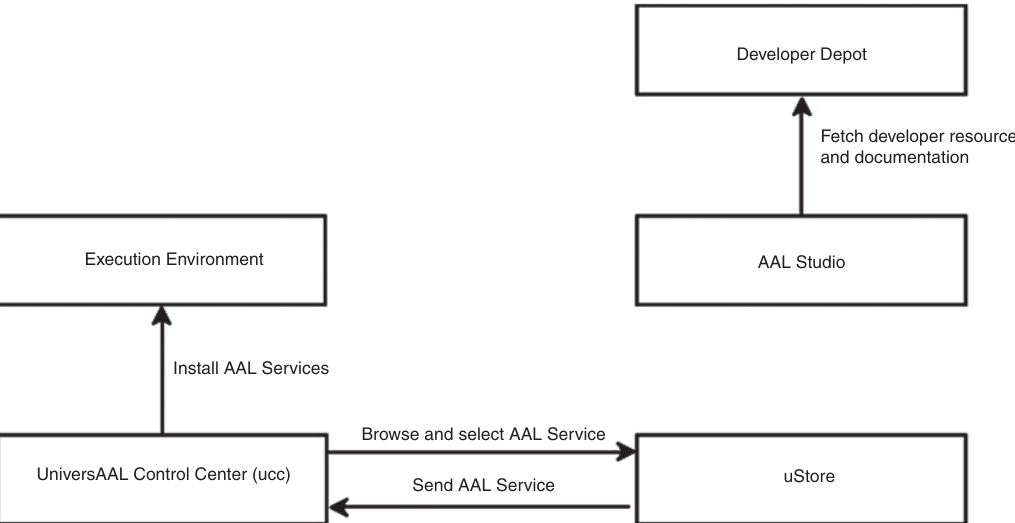
Figure 6: Overview of the Components of the UniversAAL